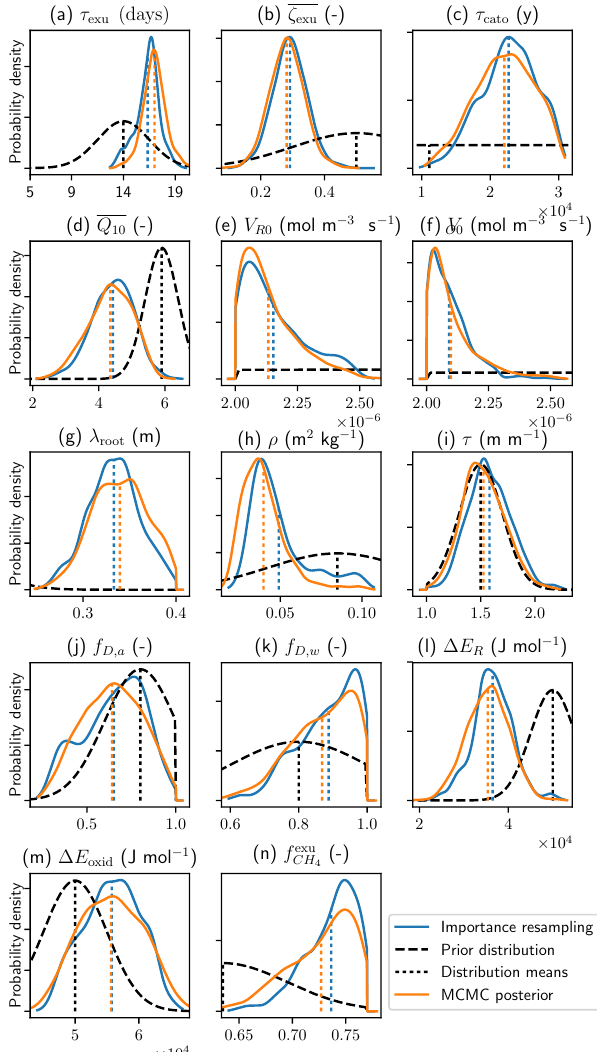
Figure 6. Posterior marginal and prior distributions from MCMC and importance resampling for all parameters: panels (a–d) and (n) are the production-related, (e–f) and (l–m) the respiration- and oxidation-related, and (g–k) the gas-transport-related parameters. The blue and orange curves shown are smoothed slightly using Gaussian kernel estimates for readability. To make these figures, 70% from the start of the MCMC chain was discarded as a warm up (orange line). The dotted vertical lines show the prior mean val- ues and the sample means from both MCMC and importance sam- pling. For the parameters ζ exu (b) and Q 10 (d) , the prior distribution drawn is the hyperprior.